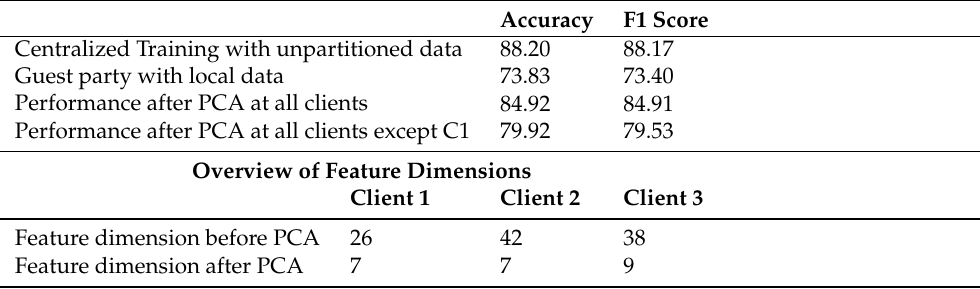
Table 5. Experimental Results on Rice MSC Dataset.